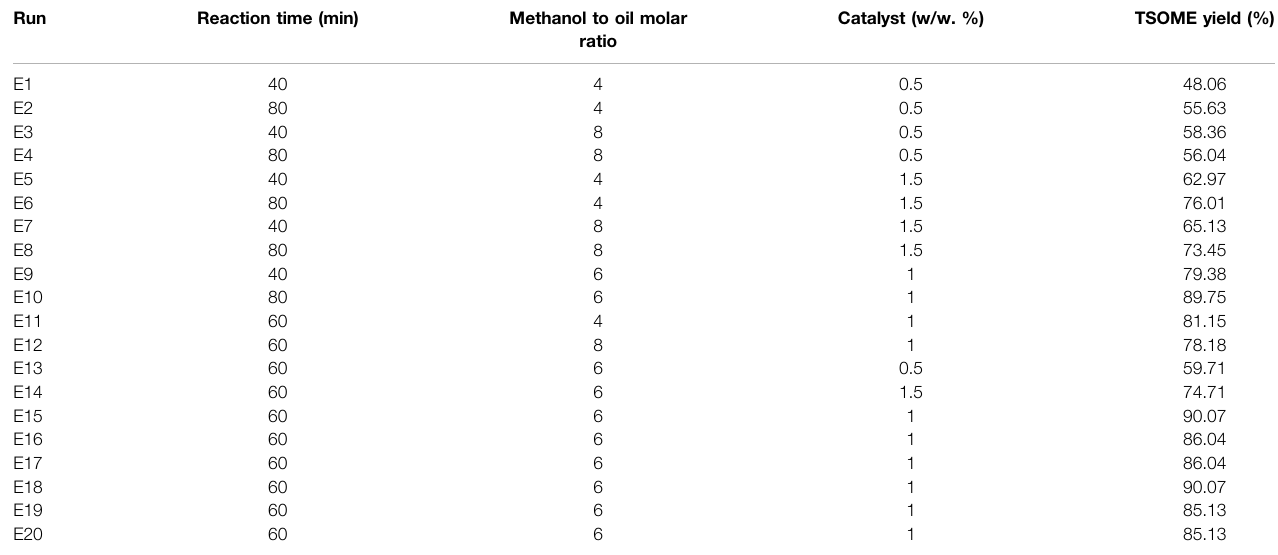
TABLE 1 | Dataset for TSOME (Waheed et al., 2015). Run Reaction time (min) Methanol to oil molar